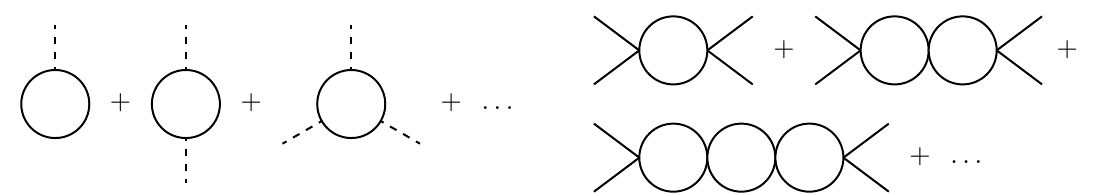
Figure 1 . Solid lines denote pions π a and dashed lines denote the Hubbard-Stratonovich field χ . Left: 1PI diagrams that contribute to the effective action at leading order in 1 /N . Right: bubble diagrams that contribute to the ππ → ππ amplitude at leading